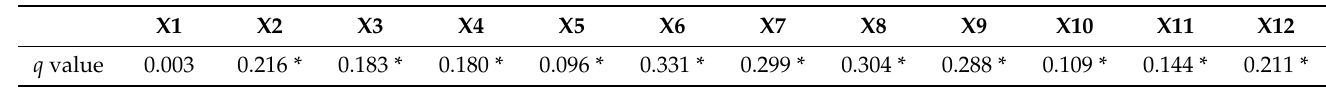
Table 4. The explanatory power of various factors on the spatial differentiation of the model villages in the YRD.